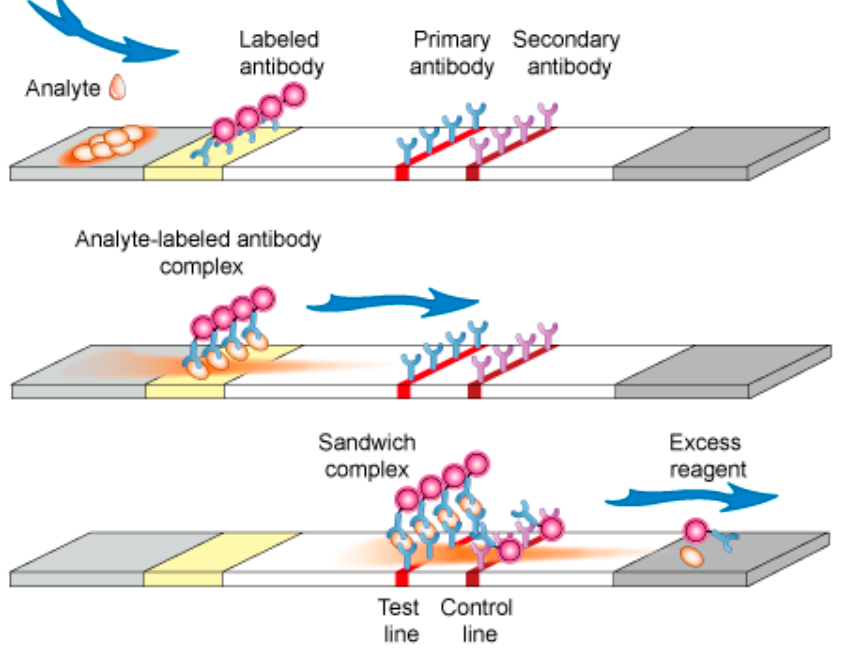
Figure 3. Sandwich immunochromatographic test [84].